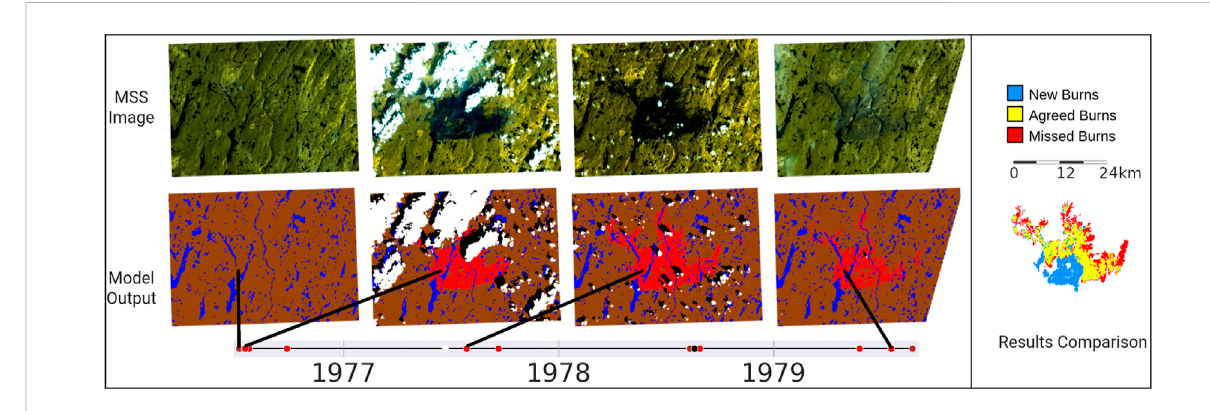
FIGURE 8 Results Detail F. MSS images and model classi fi cations of a fi re detected by our methods and listed in the existing databases, along with a timeline of each model classi fi cation for a single pixel.